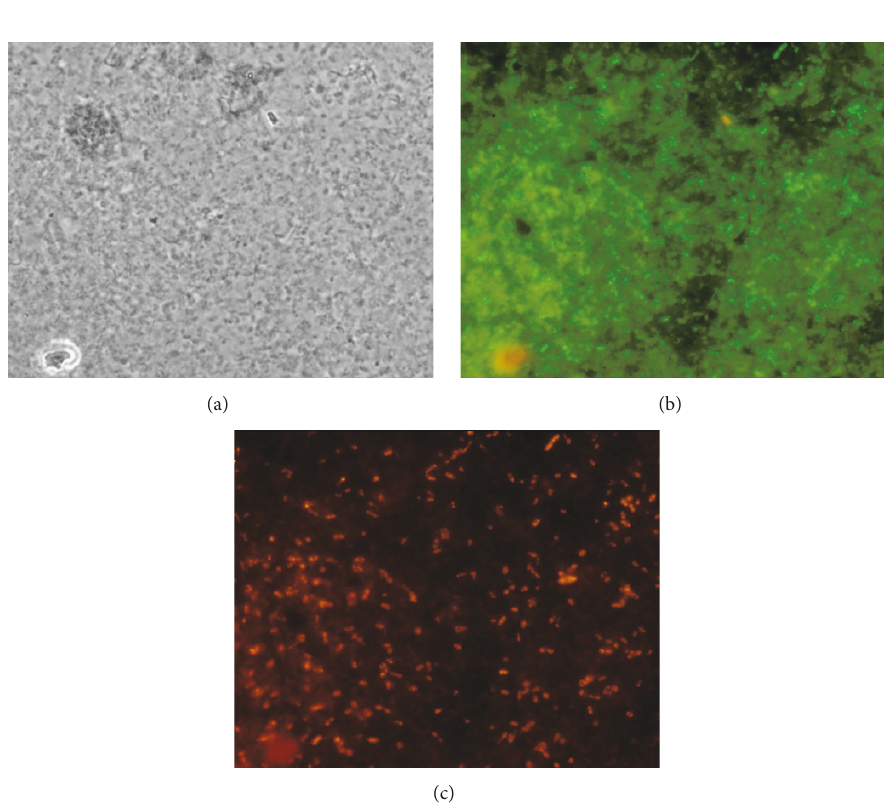
Figure 6: Micrographs (magnification: 1000x) of the flocs under phase contrast and epifluorescence. Comparison of the same floc area. Hybridization target: viable bacteria and 𝛽 1, Betaproteobacteria. (a) Phase contrast. Identical microscopic fields under fluorescence: (b) detection of all viable bacteria and (c) analysis with a specific probe for 𝛽 1-group of